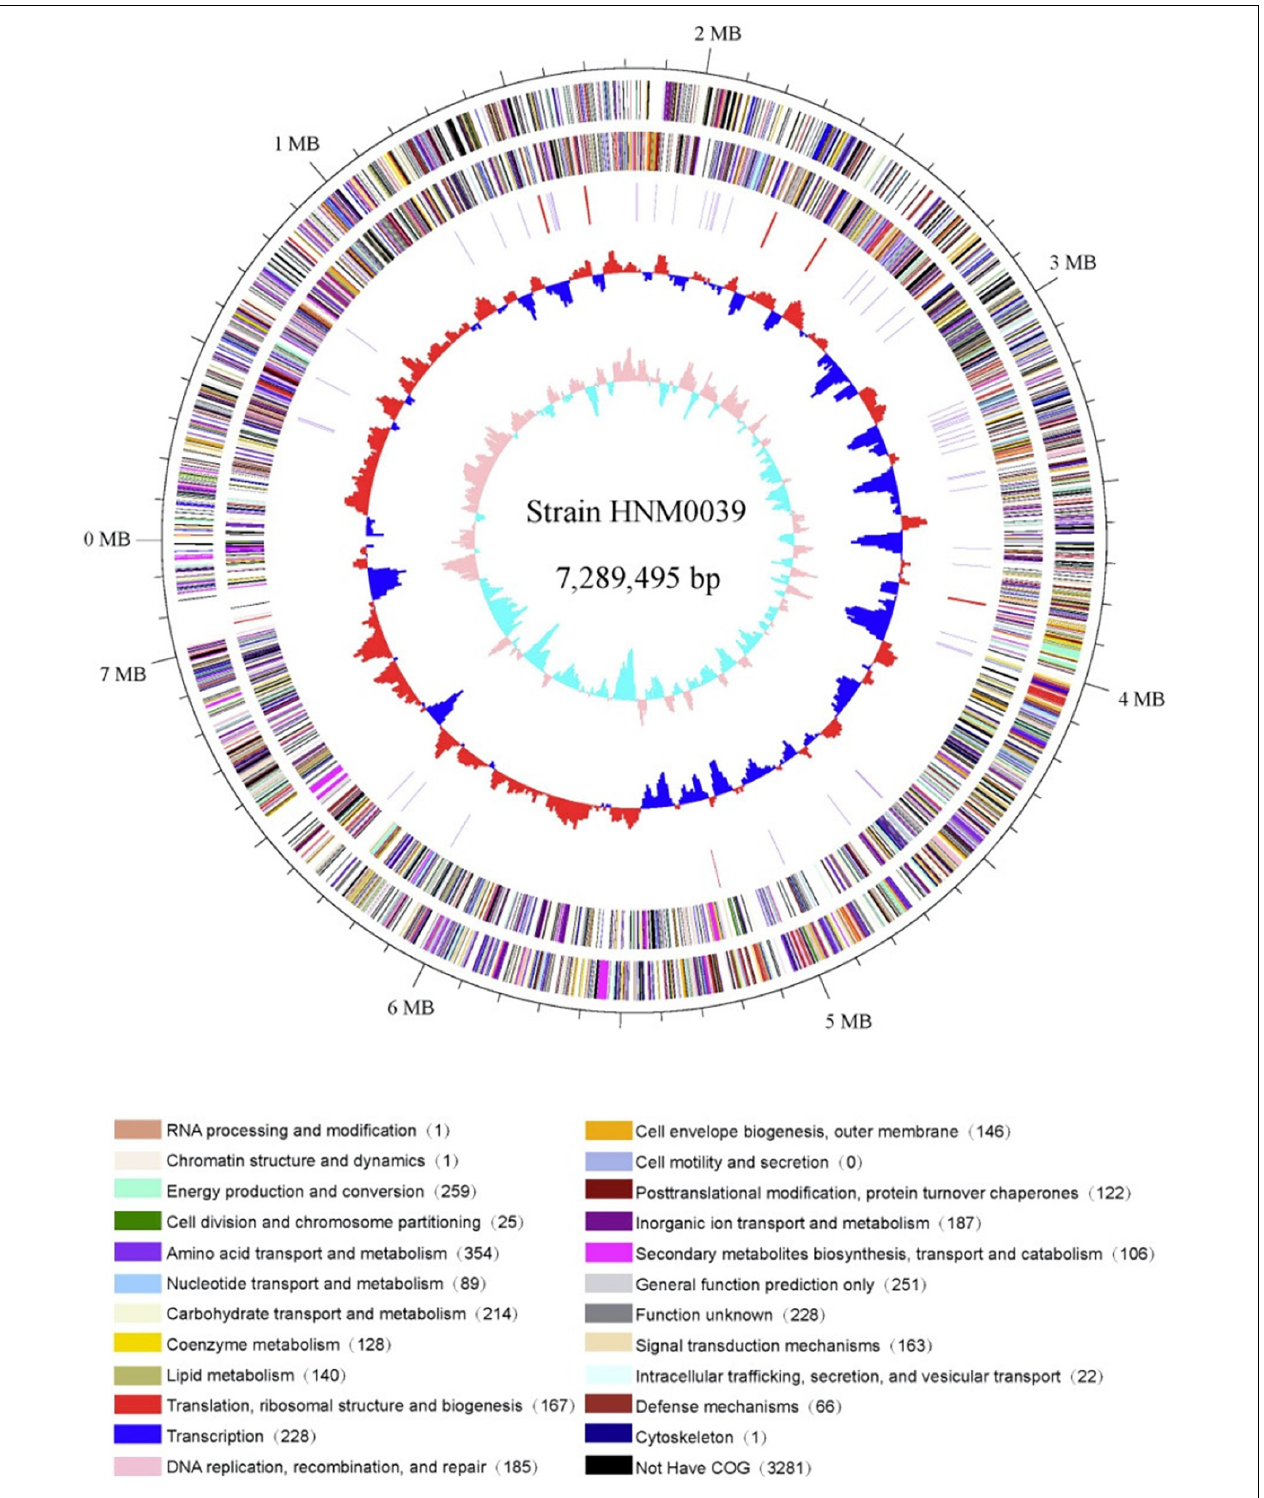
FIGURE 4 | Circular genome map of strain HNM0039 T . The genome map was made using Circos ver. 0.64 (Krzywinski et al., 2009). The outer scale is numbered in intervals of 0.1 Mbp; Circles 1 and 2 display the distribution of genes related to COG categories in the forward strand and in the backward strand respectively; Circle 3 displays the tRNA genes and rRNA genes; Circle 4 displays the GC percentage plot (red above average, blue below average); Circle 5 displays the GC skew (lime red above average, light green below average).